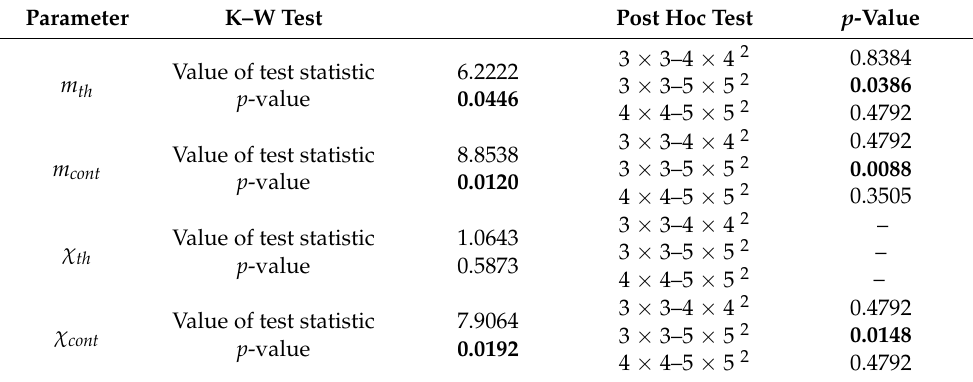
Table 9. Results of the statistical analysis for three groups: 5 × 5, 4 × 4, and 3 × 3 1 .